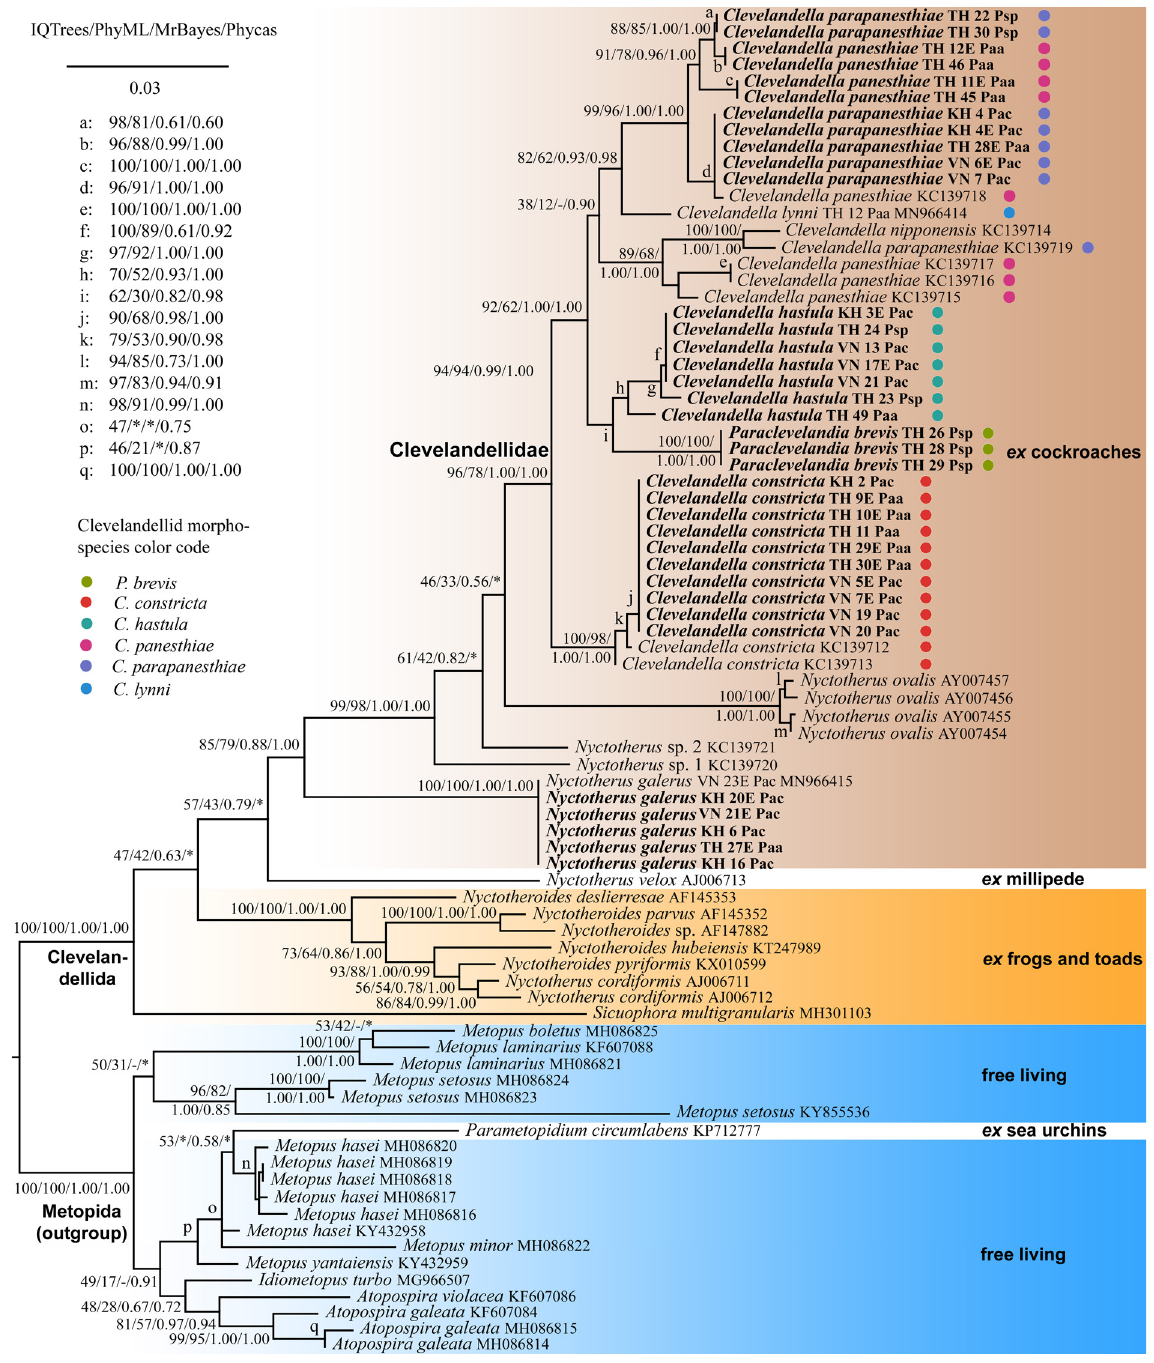
Fig. 17. Phylogeny of the order Clevelandellida de Puytorac & Grain, 1976 based on 18S rRna gene sequences. Some metopids were used as outgroup. Bootstrap values for maximum likelihood analyses performed in IQTrees and PhyML as well as posterior probabilities for Bayesian interference performed in MrBayes and Phycas were mapped onto the best scoring IQTree. Dashes indicate statistical support below 50%, asterisks denote mismatch with the topology shown. Sequences obtained in this study are in bold face. Members of each morphospecies are marked by the same color, following the code in the inset. For specimen codes and further details, see Table 6. The scale bar denotes three substitutions per one hundred nucleotide